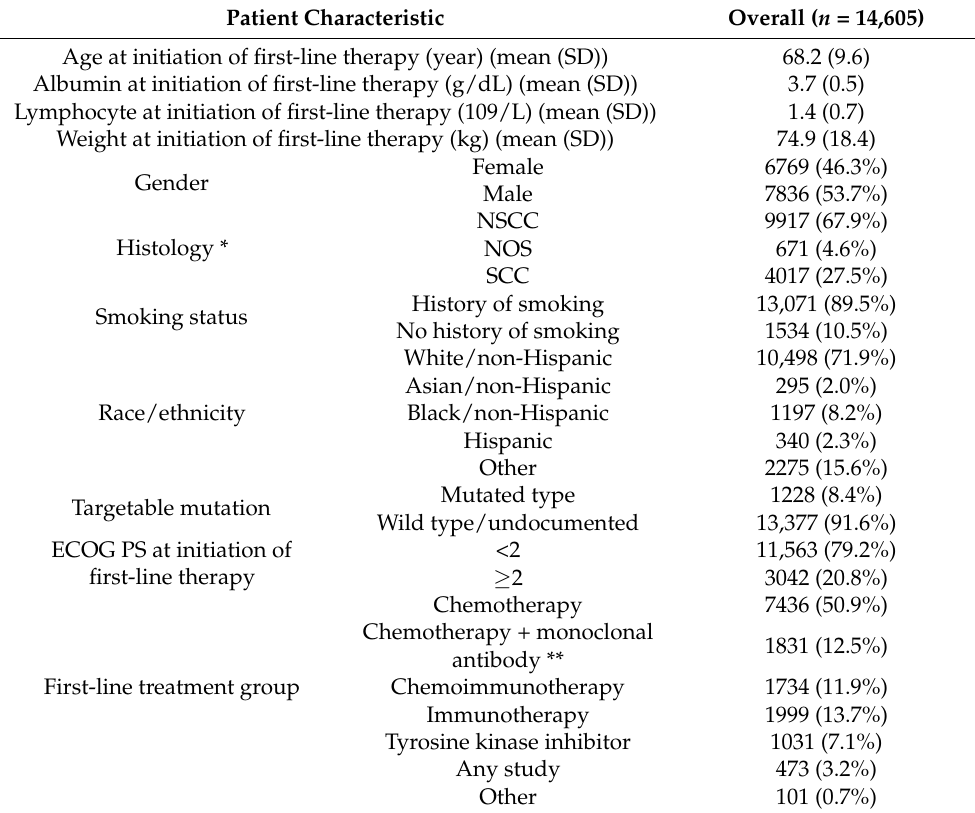
Table 1. Summary of patient characteristics at